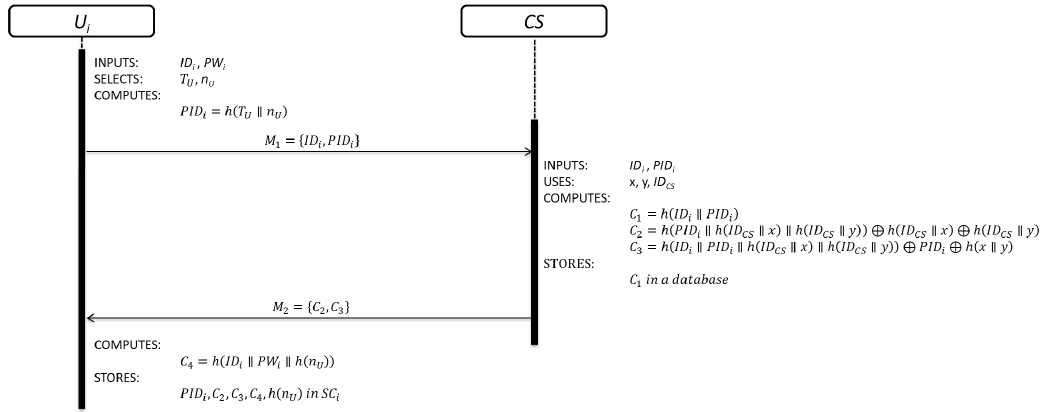
Figure 2. User registration sub-phase.